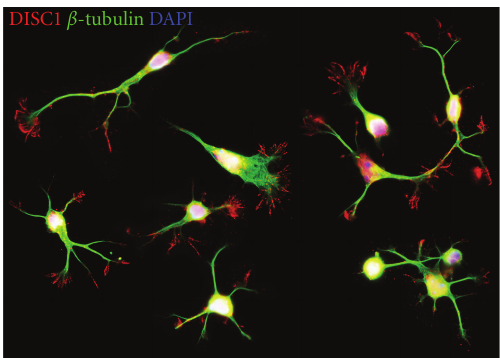
Figure 5: DISC1 immunocytochemistry on MGE-derived inter- neurons. Photomicrograph of MGE-derived neurons immunos- tained with DISC1 antibodies (red) and β -Tubulin antibodies (green) show a strong DISC1 signal in the processes of the